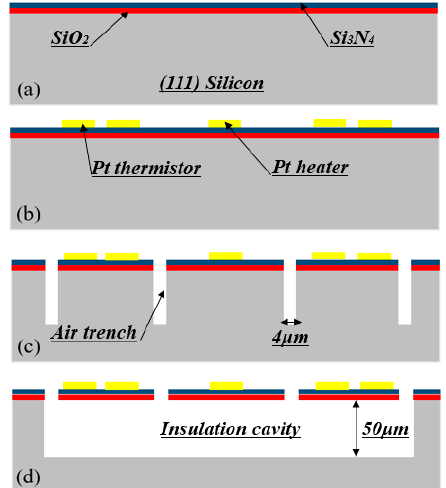
Figure 5. Detailed fabrication steps of the proposed two types of thermoresistive gas flow sensor.